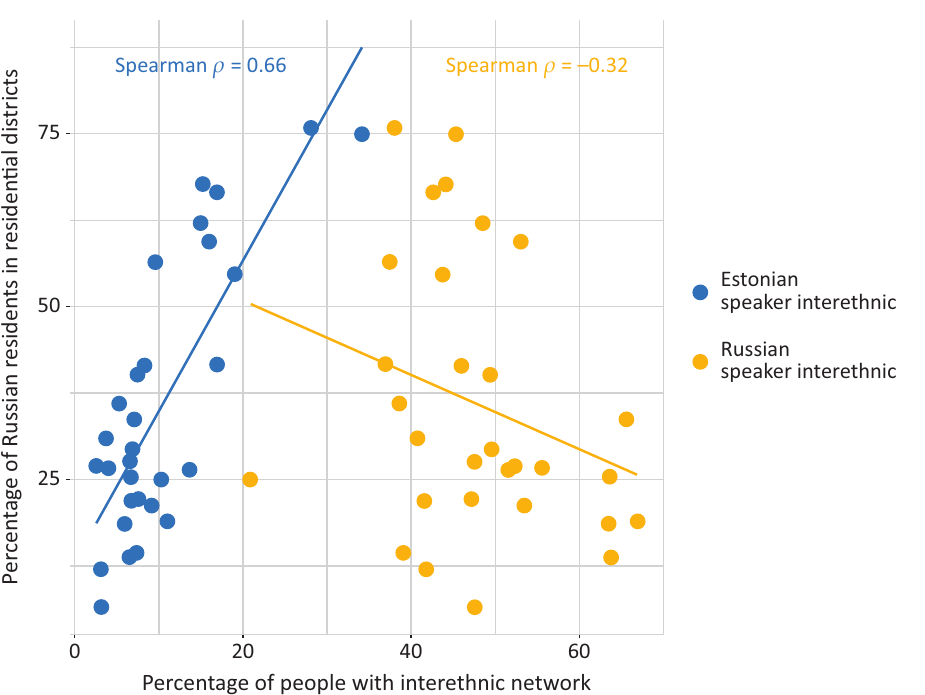
Figure 3. Correlation between proportion of interethnic networks and Russian residents in residential districts. the percentage of Russian residents is lower, i.e., more Estonians live there ( 𝜌 = − 0.32, p > 0.05).